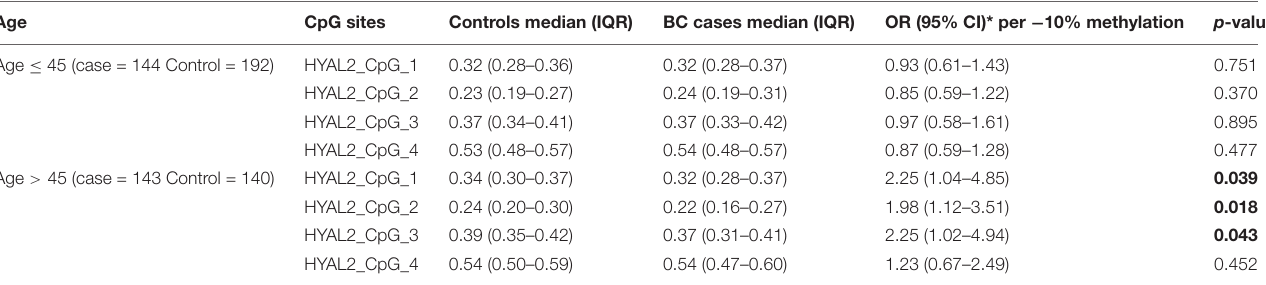
TABLE 3 | Methylation differences of HYAL2 between BC cases and controls in Study I stratify by median of age. Age CpG sites